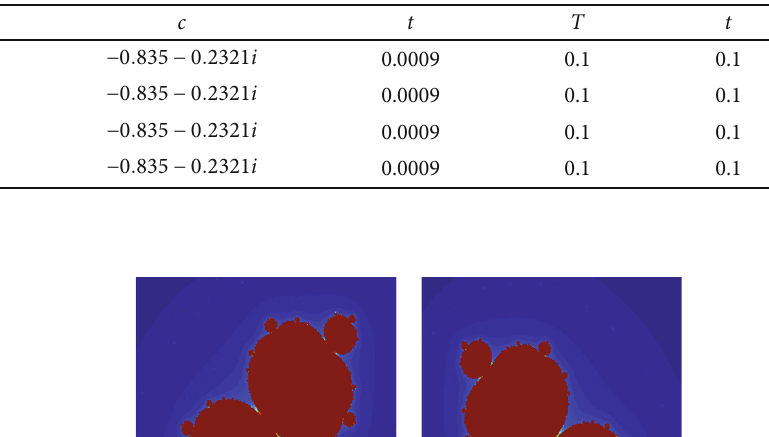
Table 2: Parameters for generation of quartic Julia set for di ff erent values of a .